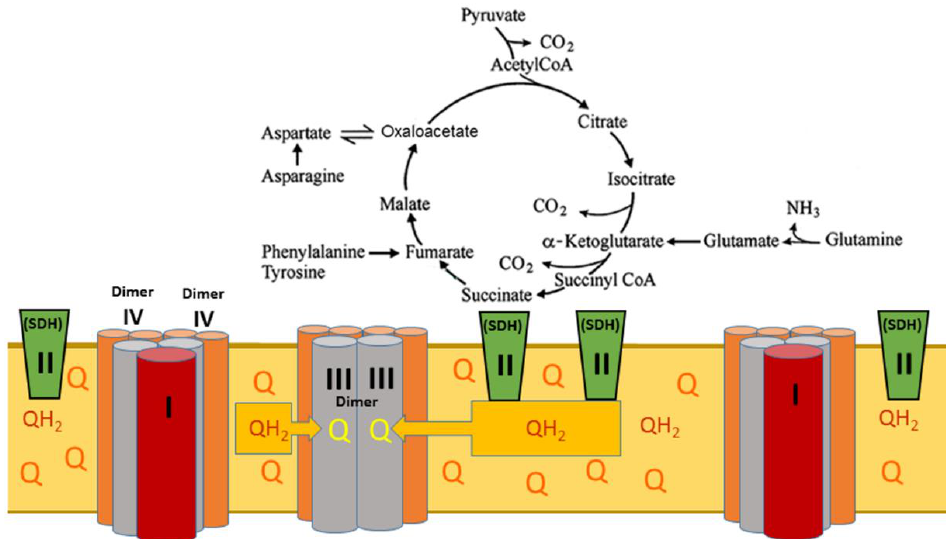
Figure 5. Succinate dehydrogenase (SDH), also known as respiratory complex II, is the only in- tramembrane enzyme of the TCA cycle. In the absence of fatty acid β -oxidation, SDH is the TCA cycle’s point of irreversibility, thus, enhancing its catabolic disposal of metabolites and producing ATP and heat at moderate rates, faster than the respiration supported by the NADH-dependent substrates. Under these conditions, the respiration rate is limited by the SDH activity as the primary source of CoQH 2 . Q — ubiquinone, the oxidized form of Coenzyme Q; QH 2 — ubiquinol, the reduced form of Coenzyme Q.